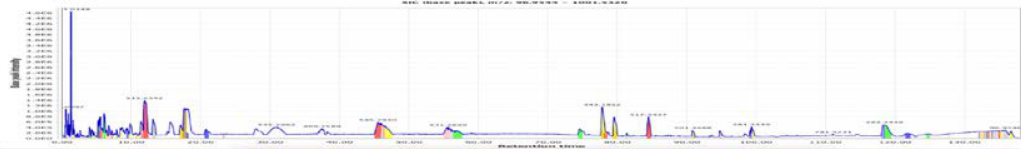
Fig. 4. Extracted ion chromatogram (XIC) of ethanol crude extract of G. boninense after peak deconvolution by local minimum search. Each individual recognized peak within the chromatogram is indicated in different colour with peak intensity and m/z value.